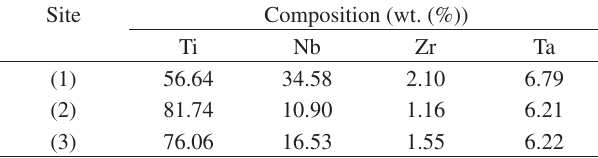
Table 1. Ti, Nb, Zr and Ta contents in the areas analyzed (EDS).